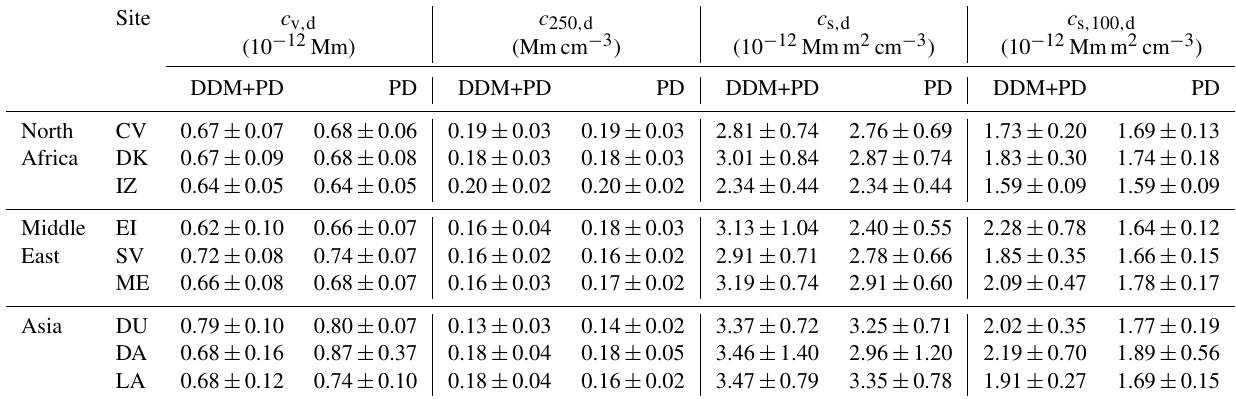
Figure 3. Relationship between aerosol extinction coefficient at 532nm and large particle (with a radius > 250nm) number concentration n 250 , d and volume concentration v d and surface area concentration s d and s 100 , d (only considering particles with a radius > 100nm) for pure dust at three typical sites, i.e., (a, d) for Cape Verde, (b, e) Dushanbe, and (c, f) Mezaira’a. The pure dust data points are selected from the AERONET V3 database (level-2.0 AOD products and level-2.0 aerosol inversions) using the threshold of particle linear depolarization ratio derived with the method given by Shin et al. (2019). The corresponding dust-related conversion factors c v , d , c 250 , d , c s , d , and c s , 100 , d are also given, respectively. Table 3. POLIPHON dust-related conversion factors c v , d (10 − 12 Mm), c 250 , d (Mmcm − 3 ), c s , d (10 − 12 Mmm 2 cm − 3 ), and c s , 100 , d (10 − 12 Mmm 2 cm − 3 ) for DDM+PD and only PD, respectively. The respective standard deviations are also provided. The sites are clas- sified into three regional clusters, including North Africa, the Middle East, and